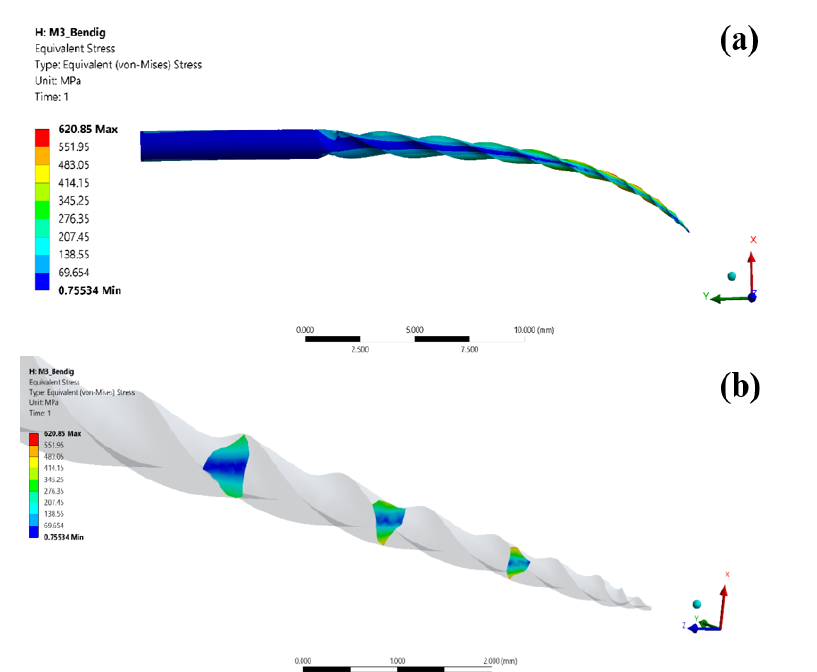
Fig. 2. Bending stresses of a) Edge Endo file (longitudinal view of the file), and b) torsion stresses in the Edge Endo file (transverse view of the file)